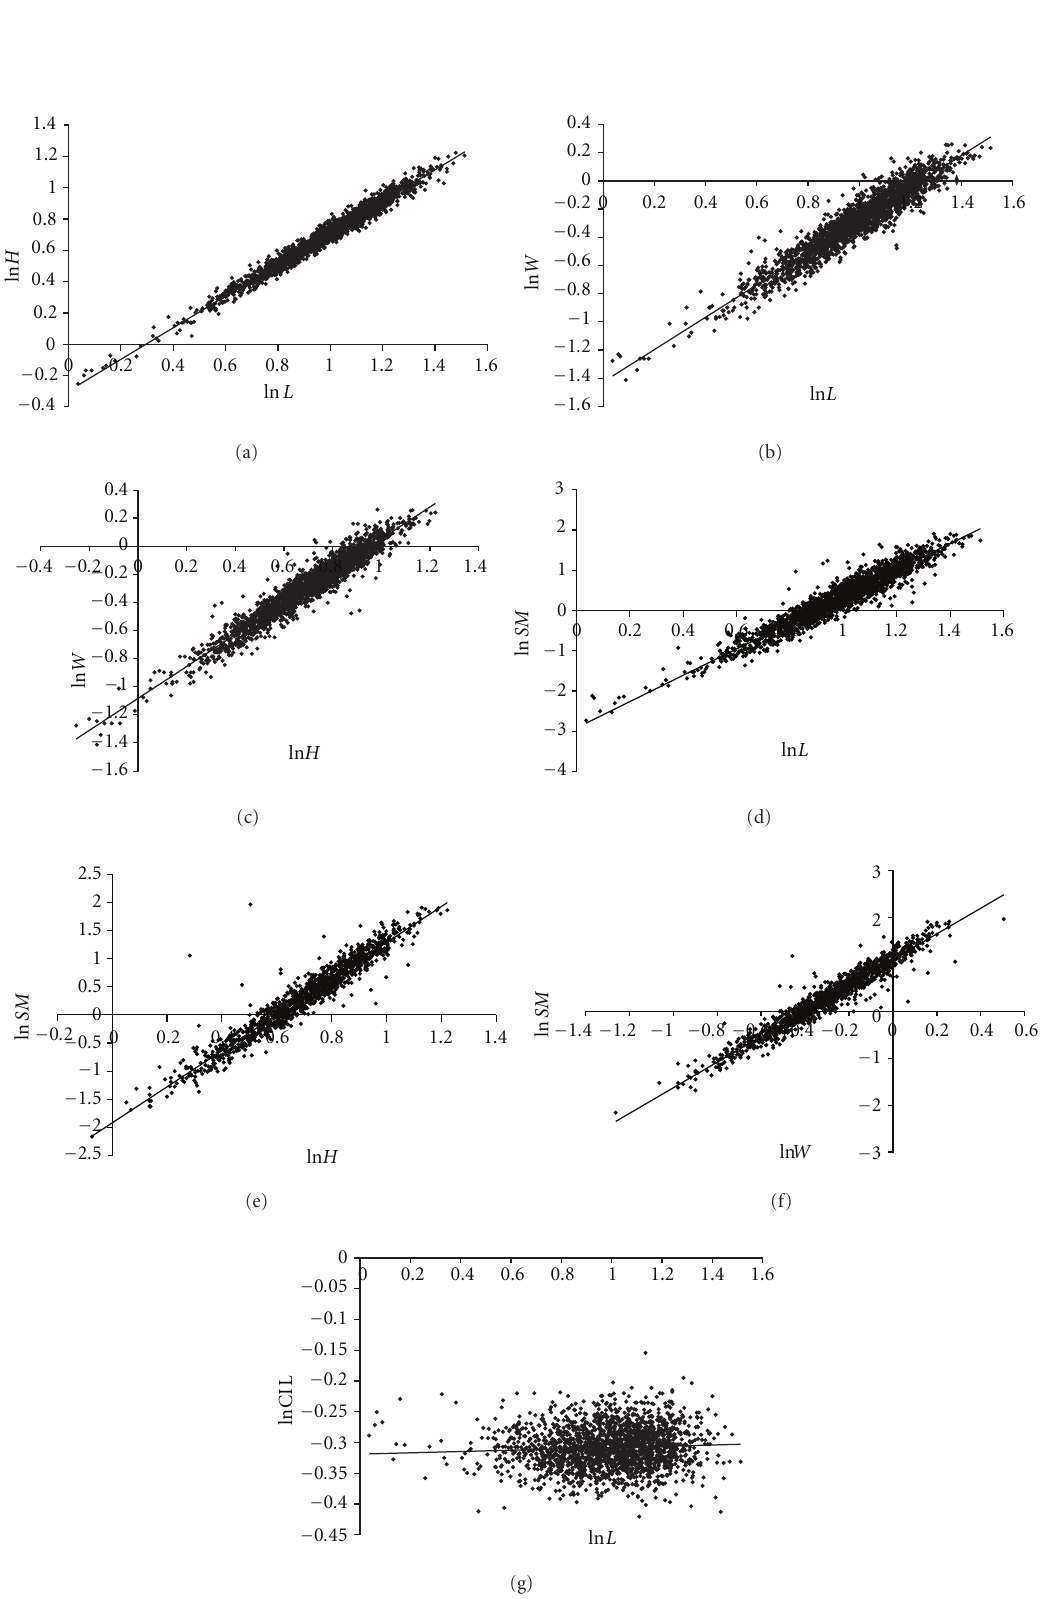
Figure 2: Allometric relations for pairs of parameters and shape descriptors (logarithmically transformed